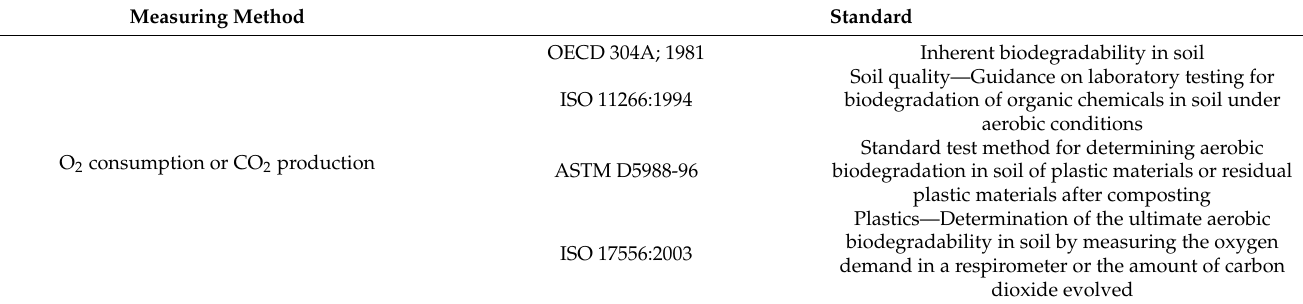
Table 1. Standards related to the biodegradability of polymers in soil environment [25]. Measuring